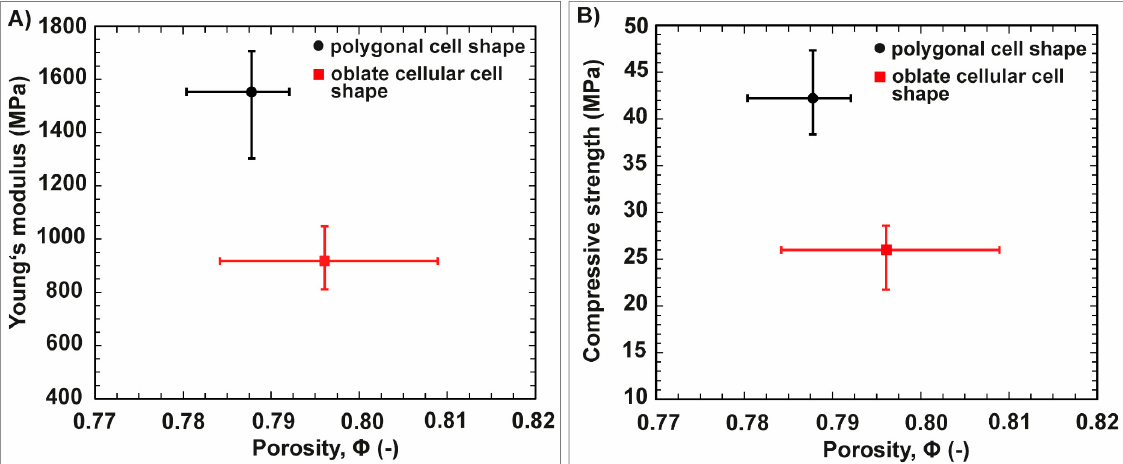
Figure 17. The plots in ( A , B ) show the average Young’s modulus and maximum compressive strength of the freeze-casted ceramics as a function of the porosity, Φ .